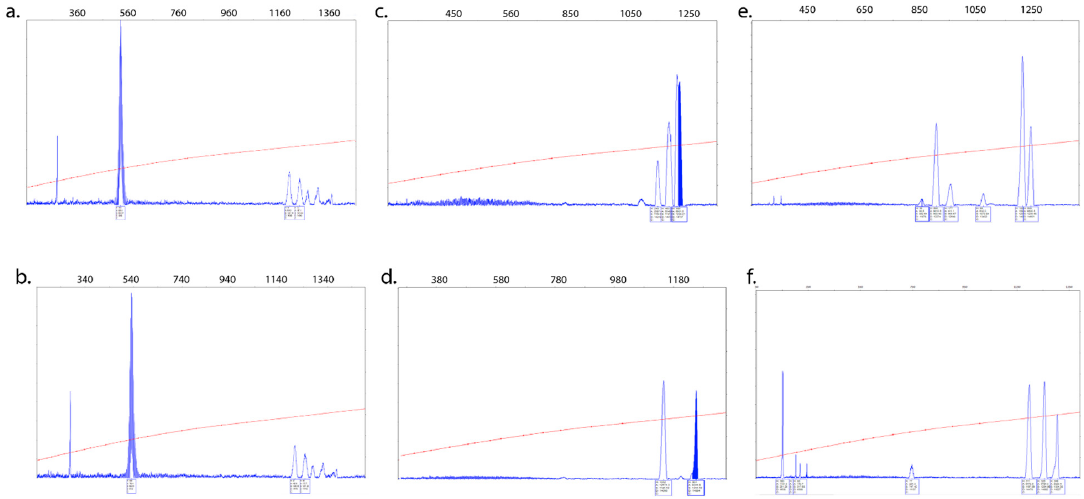
Figure 4. Size mosaicism occurs between PBMCs and urine-derived epithelial cells . Representative